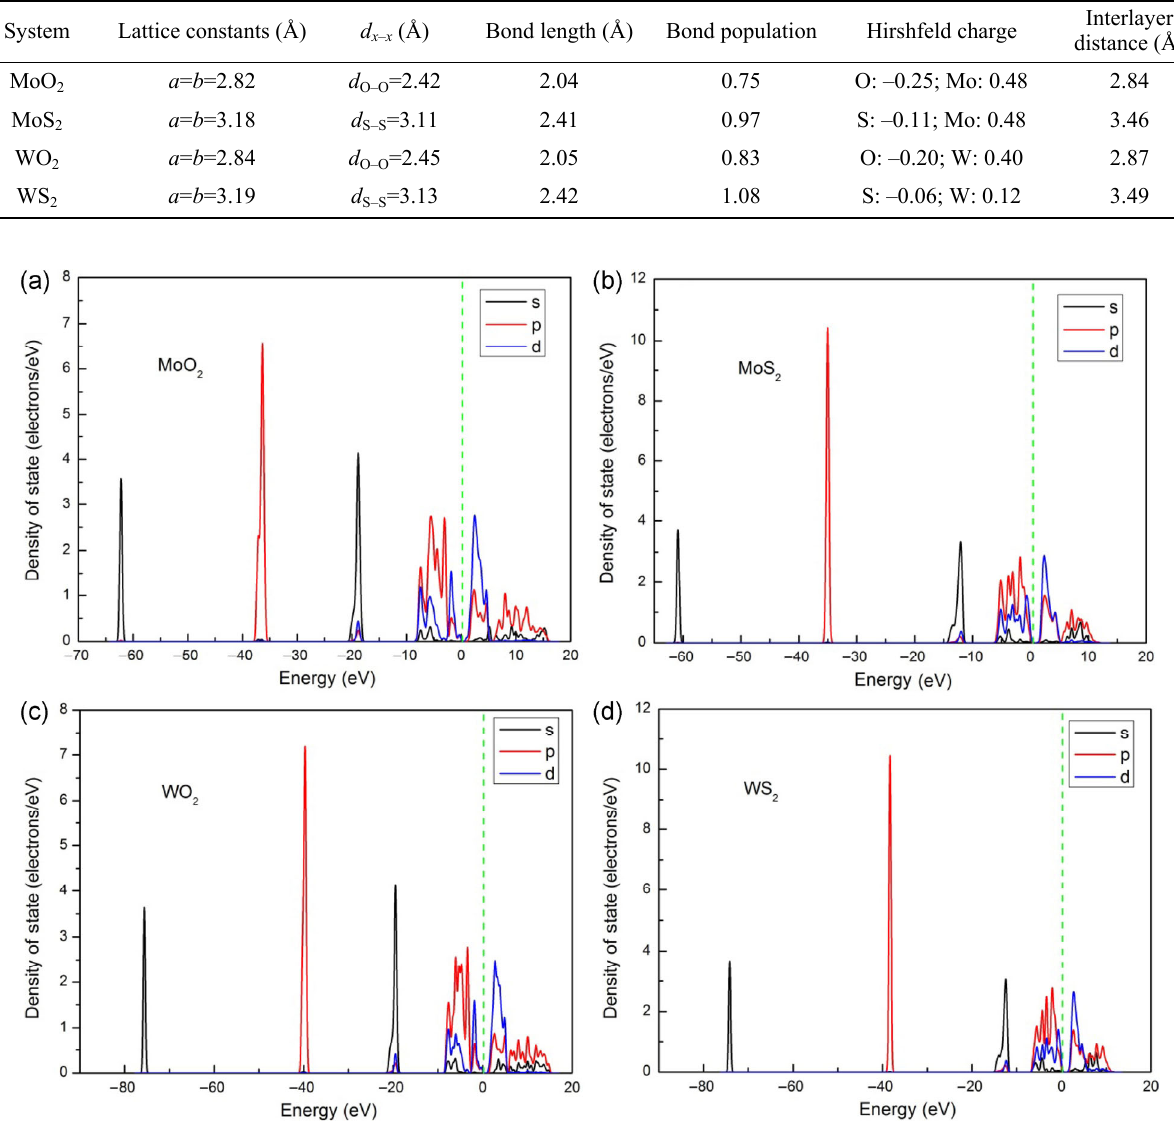
Table 1 Intrinsic property of the single layer dioxides and disulfides of molybdenum and tungsten. The interlayer distance here is the equilibrium interlayer distance between the bottom atoms of the top layer and the top atoms of the bottom layer in a commensurate condition.